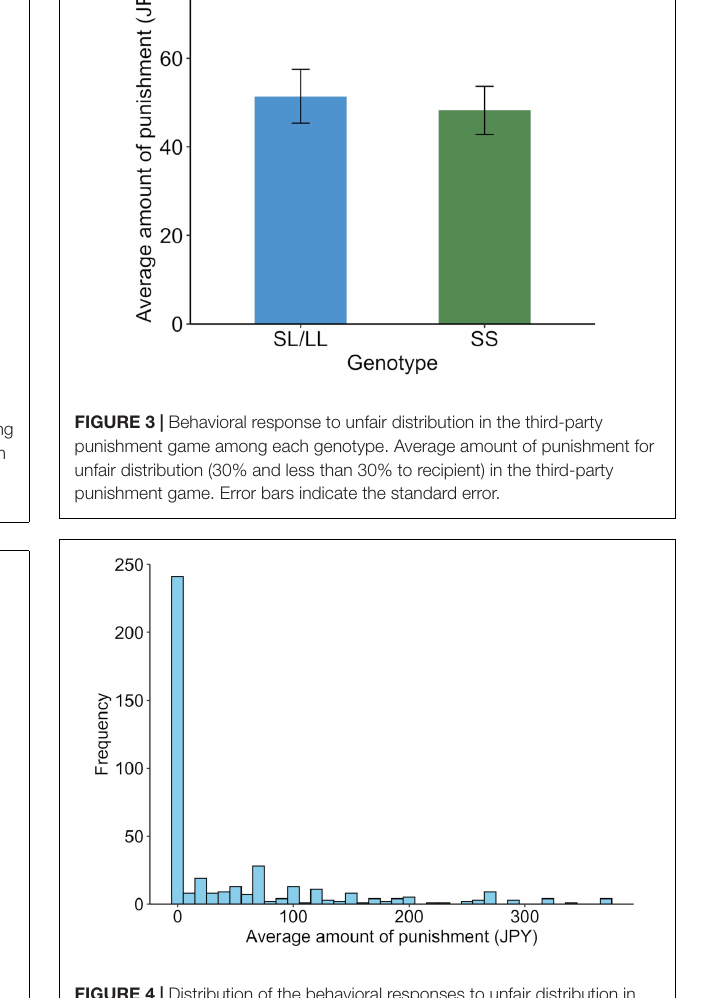
FIGURE 2 | Distribution of the behavioral responses to unfair offers in the ultimatum game. The average rejection rate of unfair offers in ultimatum games.